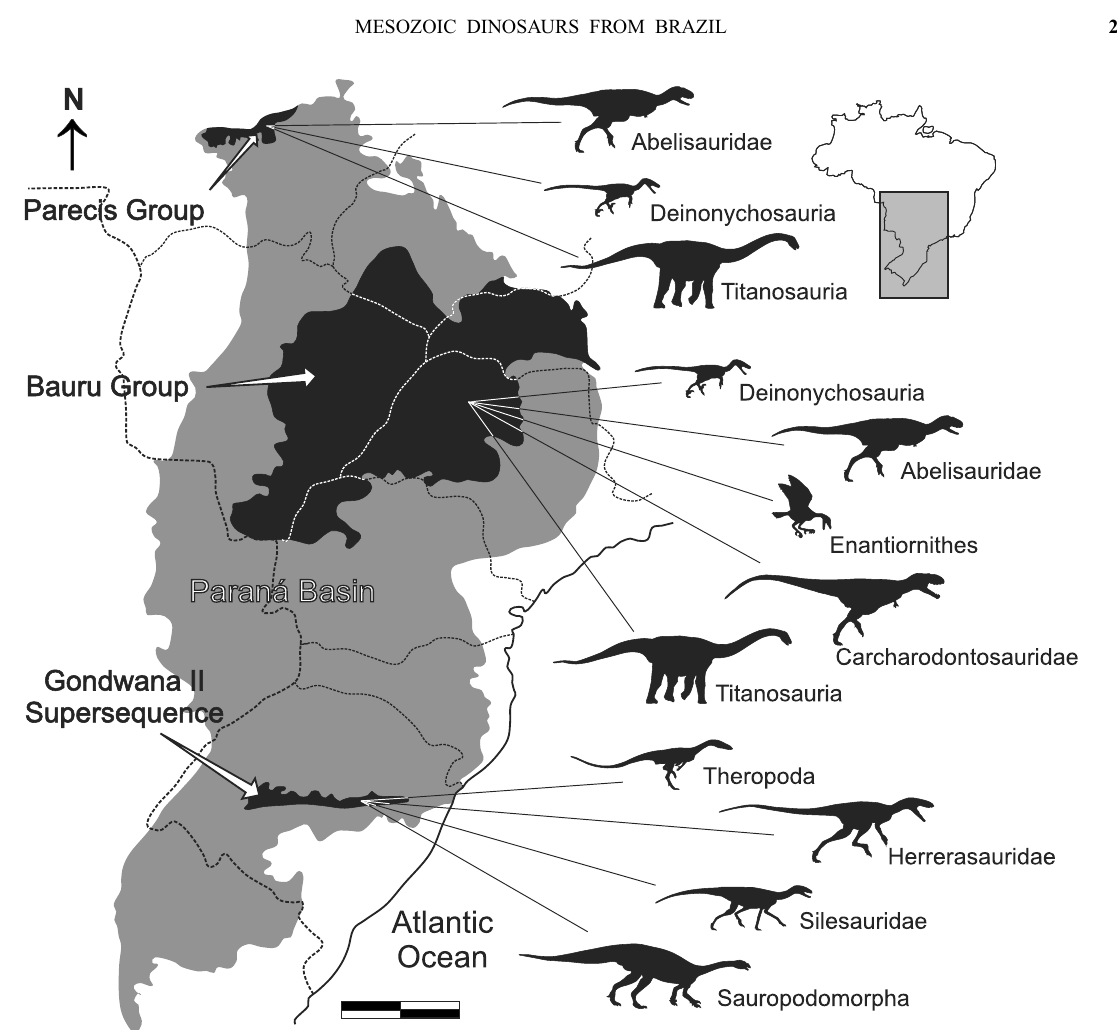
Fig. 1 – Map of south-central Brazil depicting the Paraná Basin (grey), and Gondwana II Supersequence, Bauru and Parecis groups (black). The dinosaur record follows Tables I-II. Modified from Silva et al. (2003) and Milani (2004). Scale = 200